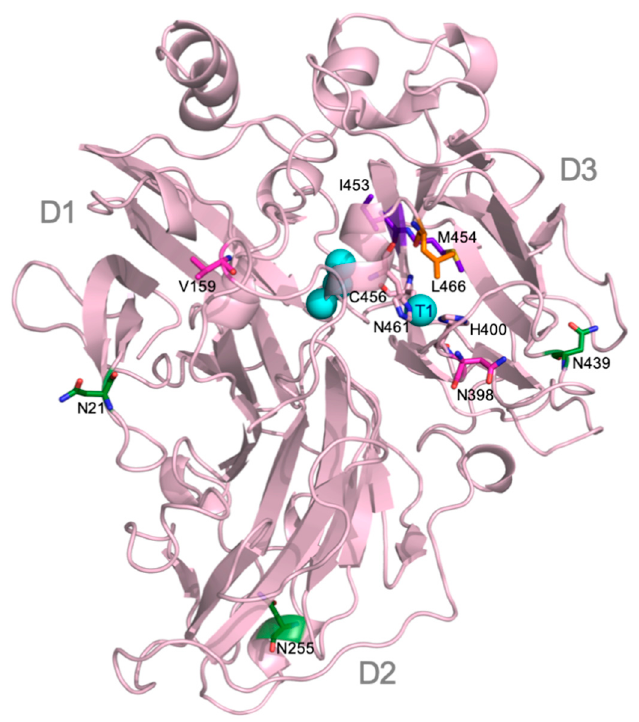
Figure 2. Structure model of native ApL represented as cartoon showing the typical folding in three cupredoxin-like domains (D1, D2 and D3), the four catalytic coppers (cyan spheres) and the two His and one Cys coordinating T1 copper (light pink sticks); residues mutated in this work are also shown as sticks: Val 159 and Asn 398 (in magenta), N-glycosylations sites Asn 21, 255 and 439 (in green); T1 “axial ligand” Leu 466 (in orange) and Ile 453 and M454 (in purple).